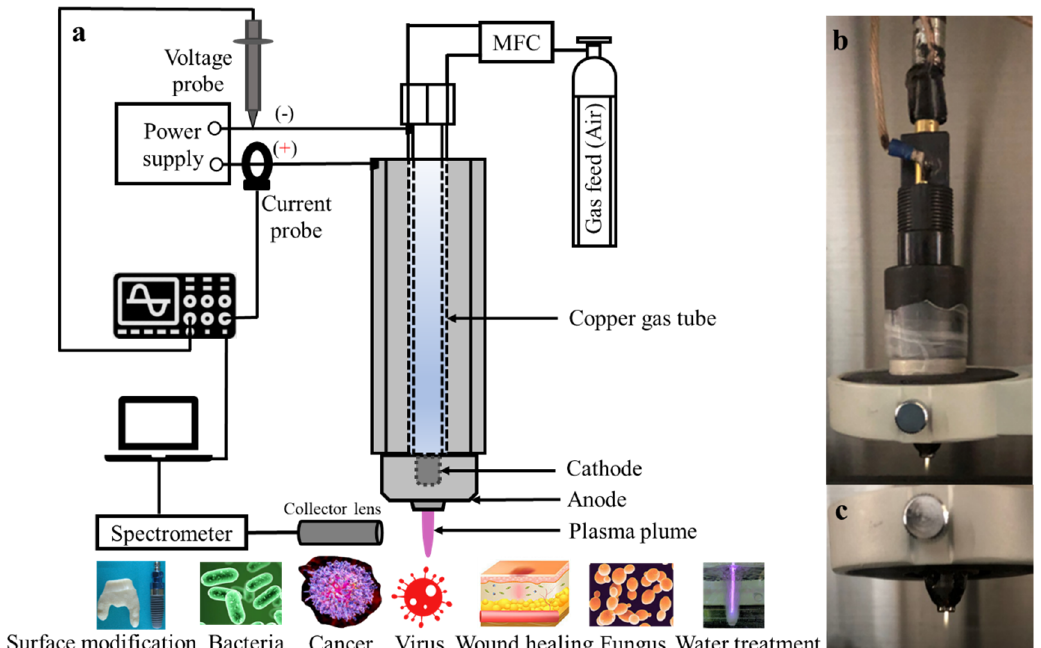
Figure 1. Schematic of diagrams: ( a ) the plasma apparatus design, ( b ) the P80 plasma cutting machine straight-handle torch, and ( c ) the plasma plume produced at room temperature under ambient pressure.